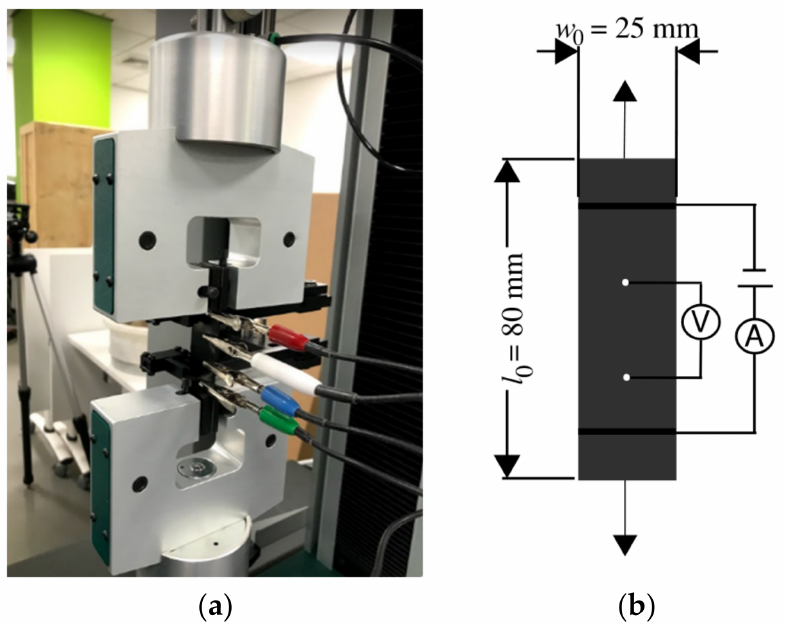
Figure 2. ( a ) Tensile test and resistance measurement, ( b ) Scheme of electrical resistance interrogation system.